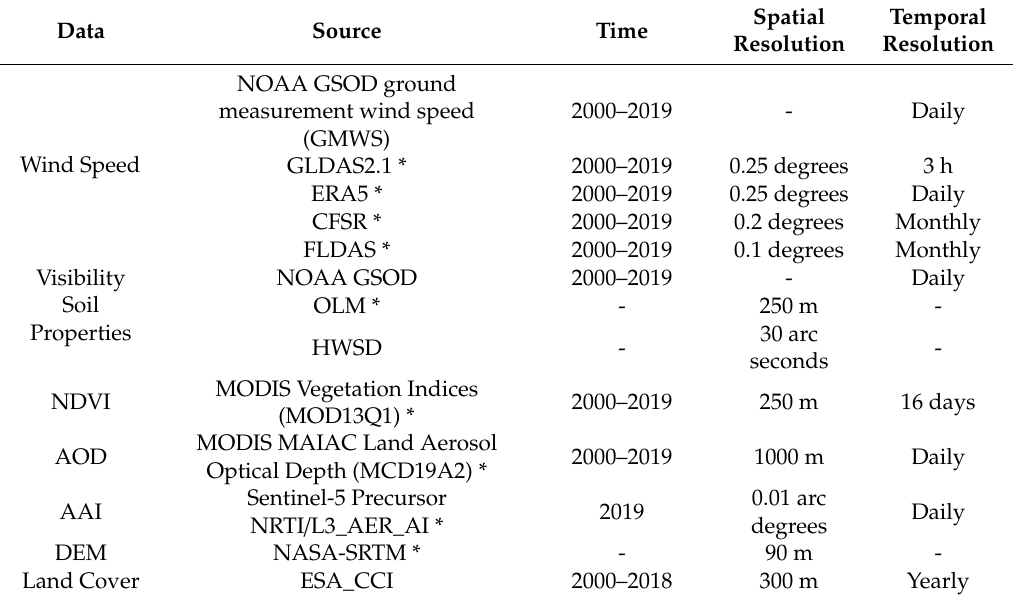
Table 1. Data collection and